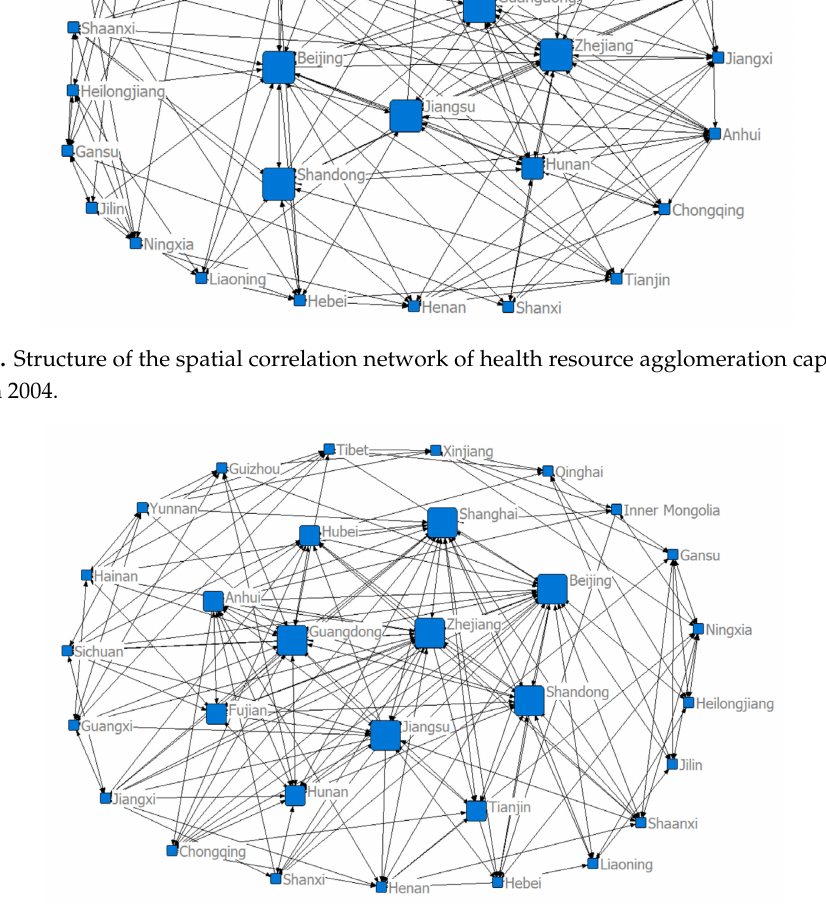
Figure 5. Structure of the spatial correlation network of health resource agglomeration capacities in China in